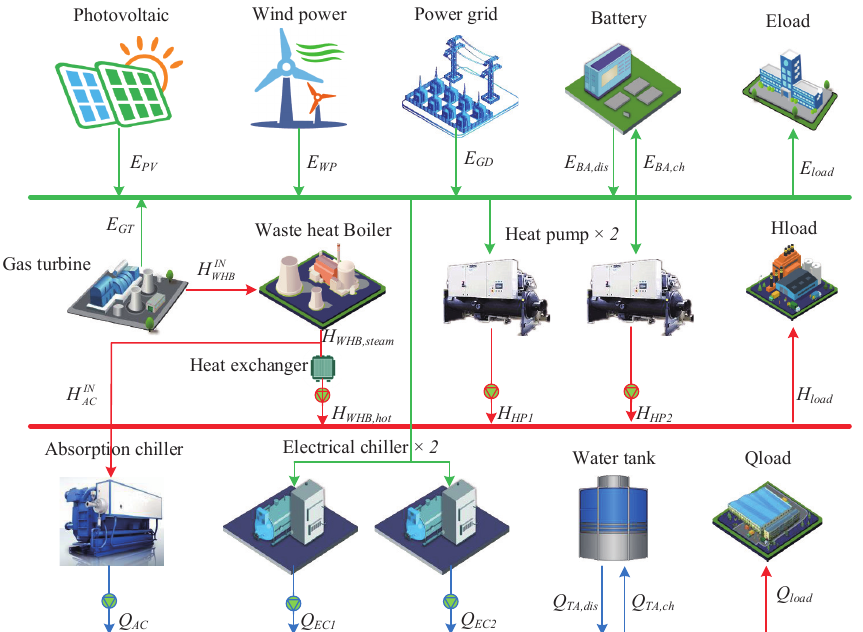
Figure 1. Schematic configuration of the IES.